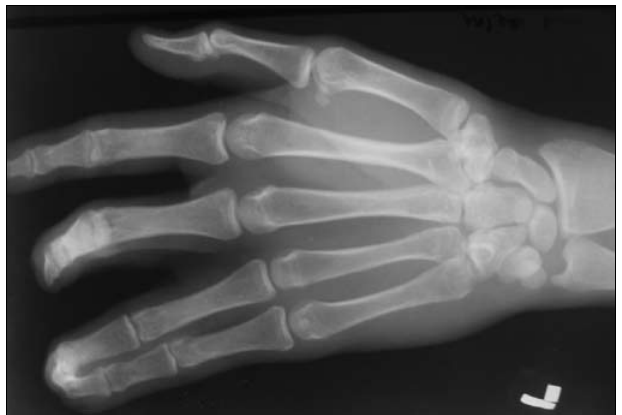
Fig. 4. Hand-wrist radiograph showing bony fusion of the terminal 4th and 5th terminal phalanges.